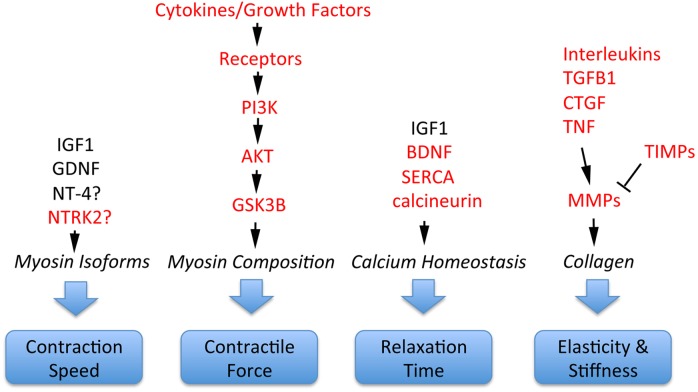
Involvement of schizophrenia-related genes and gene products (red font) within signaling pathways that regulate key functions of extraocular muscle development and plasticity.The indicated genes and gene products are important for generating superfast contractions (saccades), adjusting muscle force, relaxation time, and the elastic properties essential for eye movements. For details, see Kjaer (2004), Li, Feng & Von Bartheld (2011), Stager Jr, McLoon & Felius (2013), Mienaltowski & Birk (2014), Agarwal et al. (2016) and Nelson, Stevens & McLoon (2016).